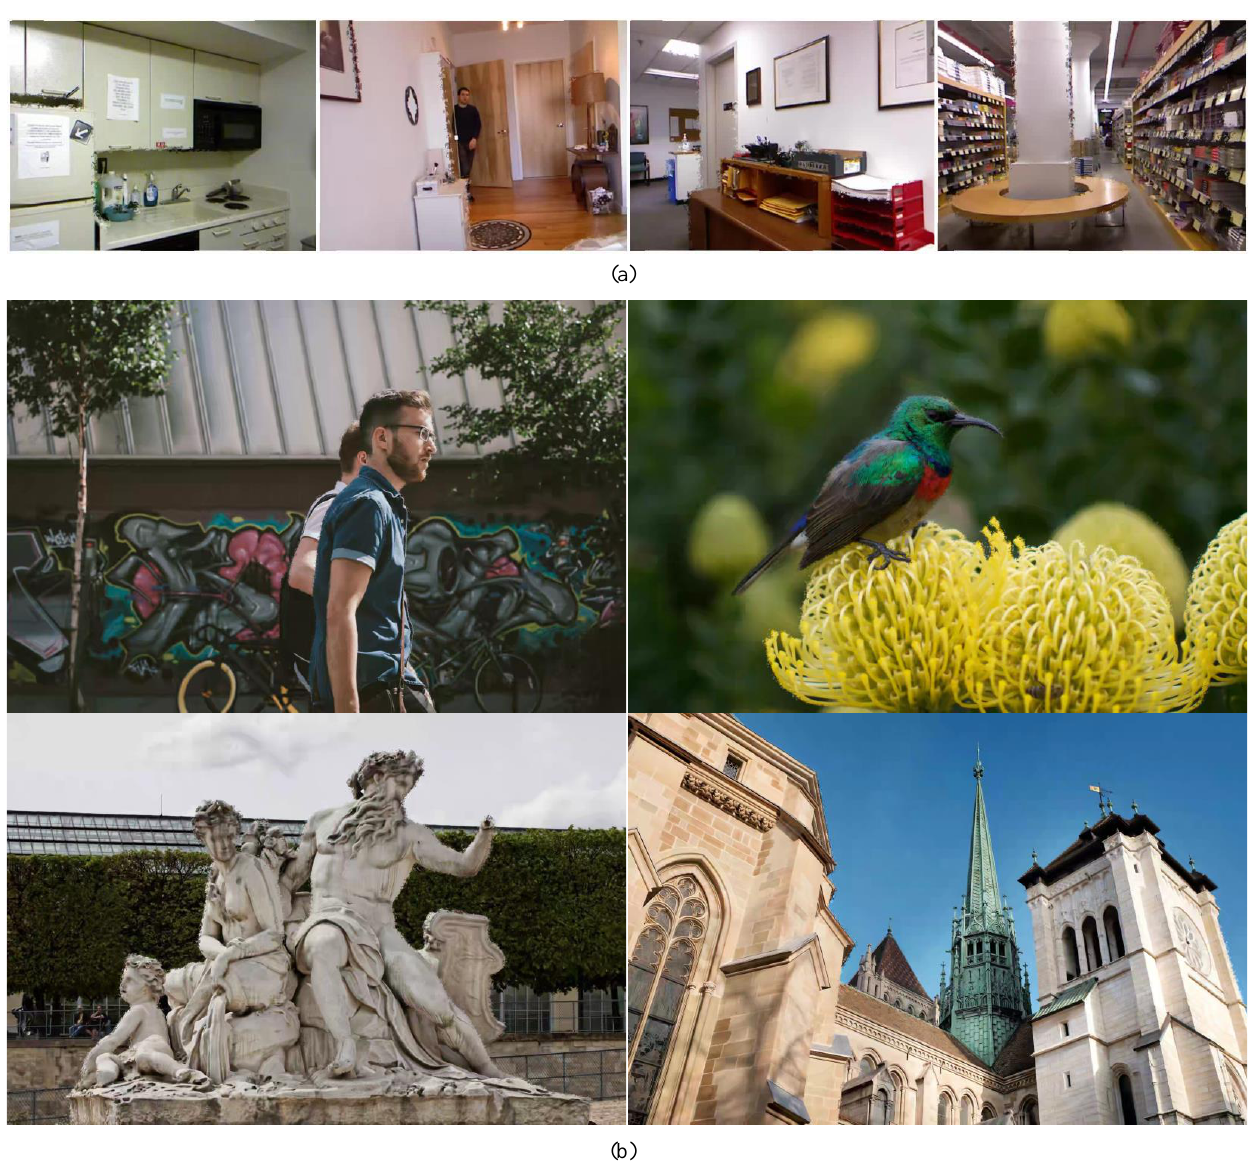
Figure 6. Example images of NYU- and DIV2K-based synthetic image datasets. Zooming for better viewing of synthetic DIBR distortion. ( a ) NYU-based synthetic images. ( b ) DIV2K-based synthetic images. Table 3. Dataset